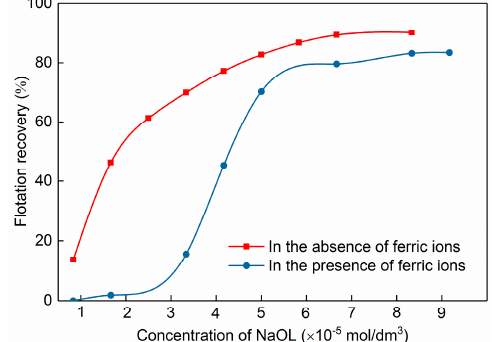
Figure 13. Flotation recovery of celestite as a function of NaOL concentration in the absence and presence of ferric ions, (ferric ion: 5 × 10 − 5 mol / dm 3 , pH = 8).